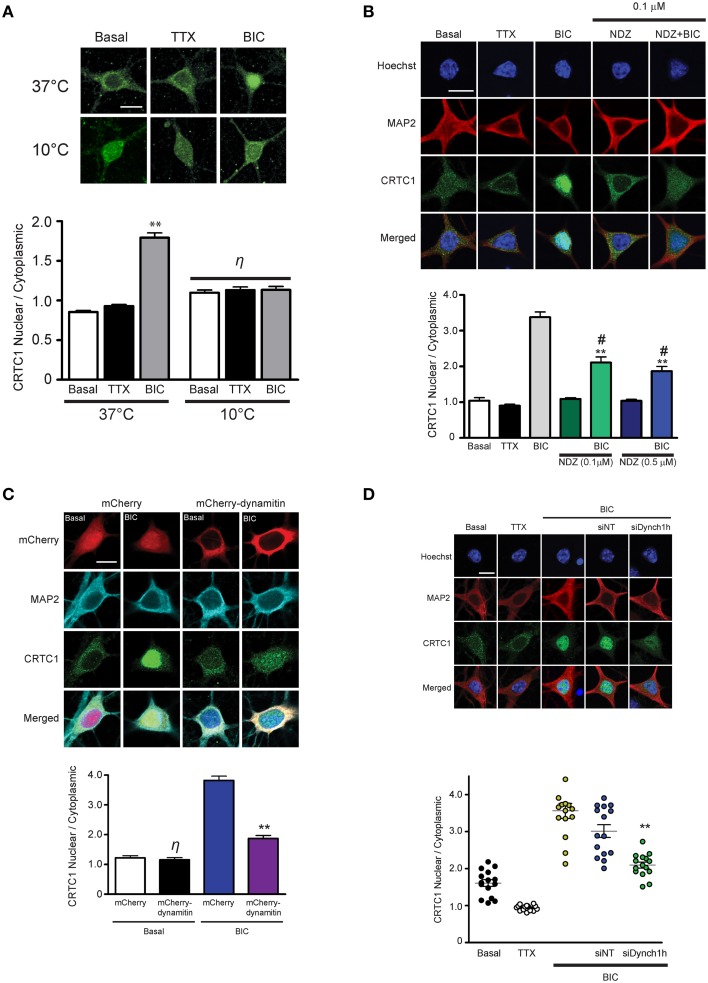
Nuclear accumulation of CRTC1 involves active, dynein-mediated transport along microtubules. (A) Neurons were stimulated with either TTX or BIC in incubators at 37°C or 10°C. CRTC1 nuclear to cytoplasmic ratio was quantified (**p < 0.001 relative to basal; η: not significant). (B) Neurons were incubated with nocodazole (NDZ, 0.1 μM or 0.5 μM) to depolymerize microtubules prior to BIC stimulation (**p < 0.001 relative to non-BIC samples #p < 0.001 relative to BIC). (C) Neurons expressing either mCherry or mCherry-dynamitin were stimulated with BIC. Endogenous expression of CRTC1 in the nucleus and cytoplasm of mCherry expressing neurons were quantified (**p < 0.001 relative to mCherry only samples; η: not significant relative to basal mCherry). (D) Mouse hippocampal neurons (21–28 DIV) were incubated with dynein heavy chain siRNA (siDynch1h) or non-targeted control (siNT) followed by stimulation with TTX or BIC (**p < 0.001 relative to all other BIC samples). All scale bars = 10 μm.